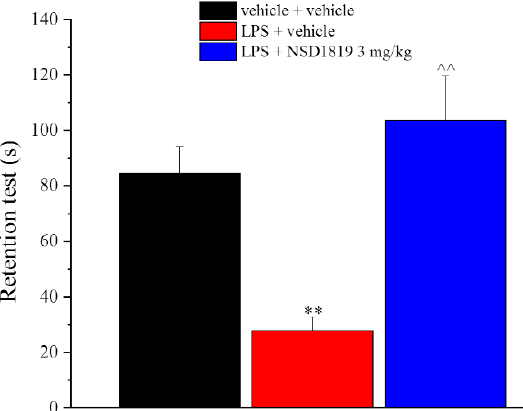
Figure 5. Effect of NSD1819 on LPS-induced memory loss. LPS (1 mg/kg) was intraperitoneally injected for five consecutive days (from 1 to 5). NSD1819 was suspended in 1% carboxymethylcellulose sodium salt (CMC) and daily orally administered starting from day 1 until the end of the experiment. Control animals were treated with vehicles. On day 8, 16 h after the last administration of the compound, the memory was assessed by the Passive avoidance test. Data are expressed as the mean ± S.E.M. of values from 8 mice analyzed in 2 different experimental sets. ** p < 0.01 vs. vehicle + vehicle; ^^ p < 0.01 vs. LPS + vehicle.